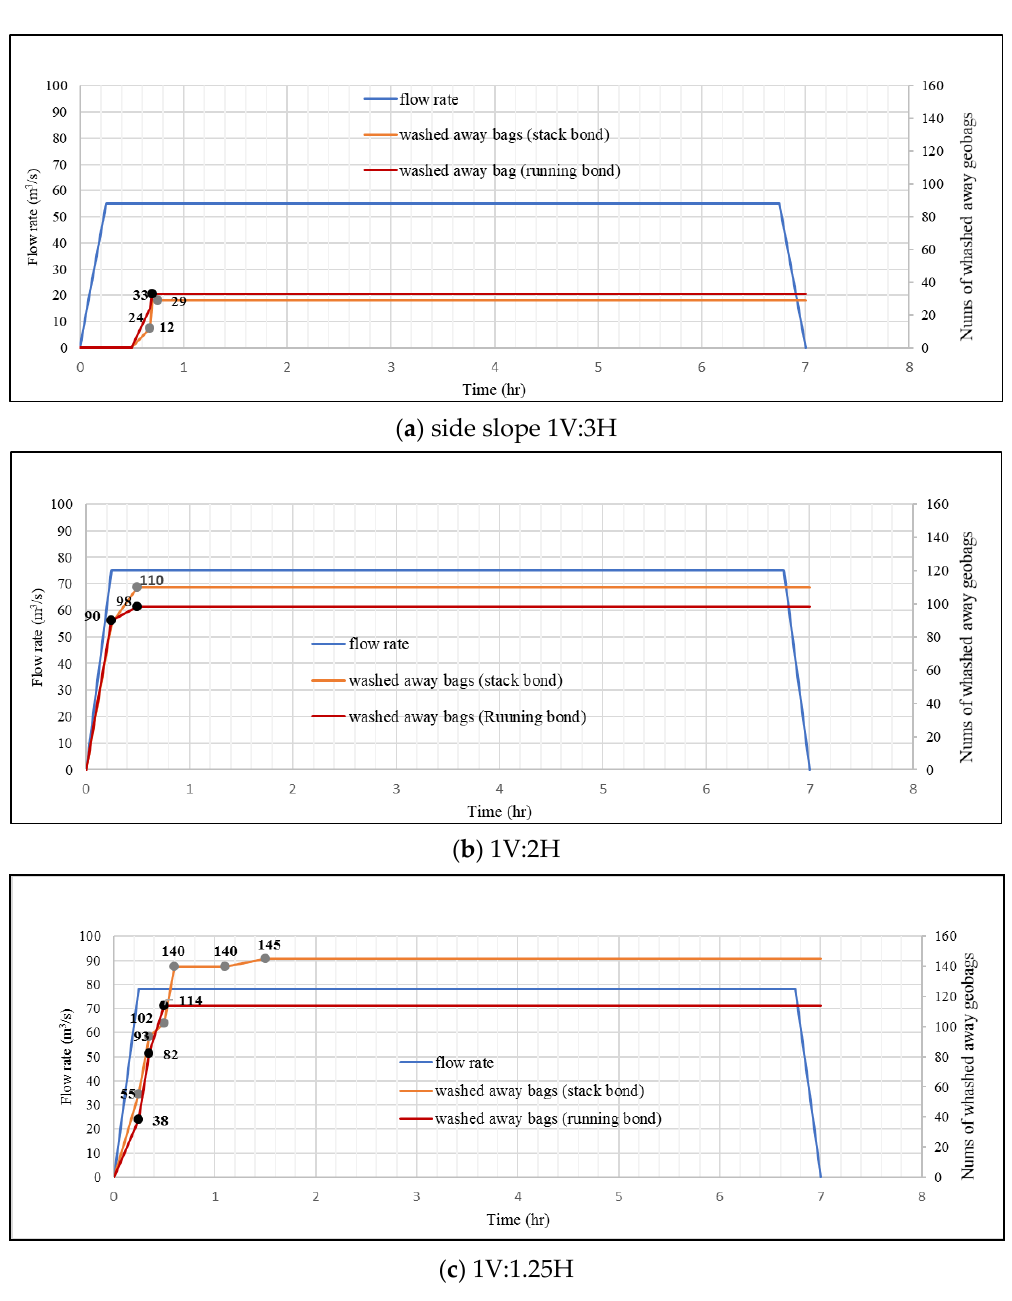
Figure 4. Temporal analysis of failure processes (water depths 60–80% of revetment